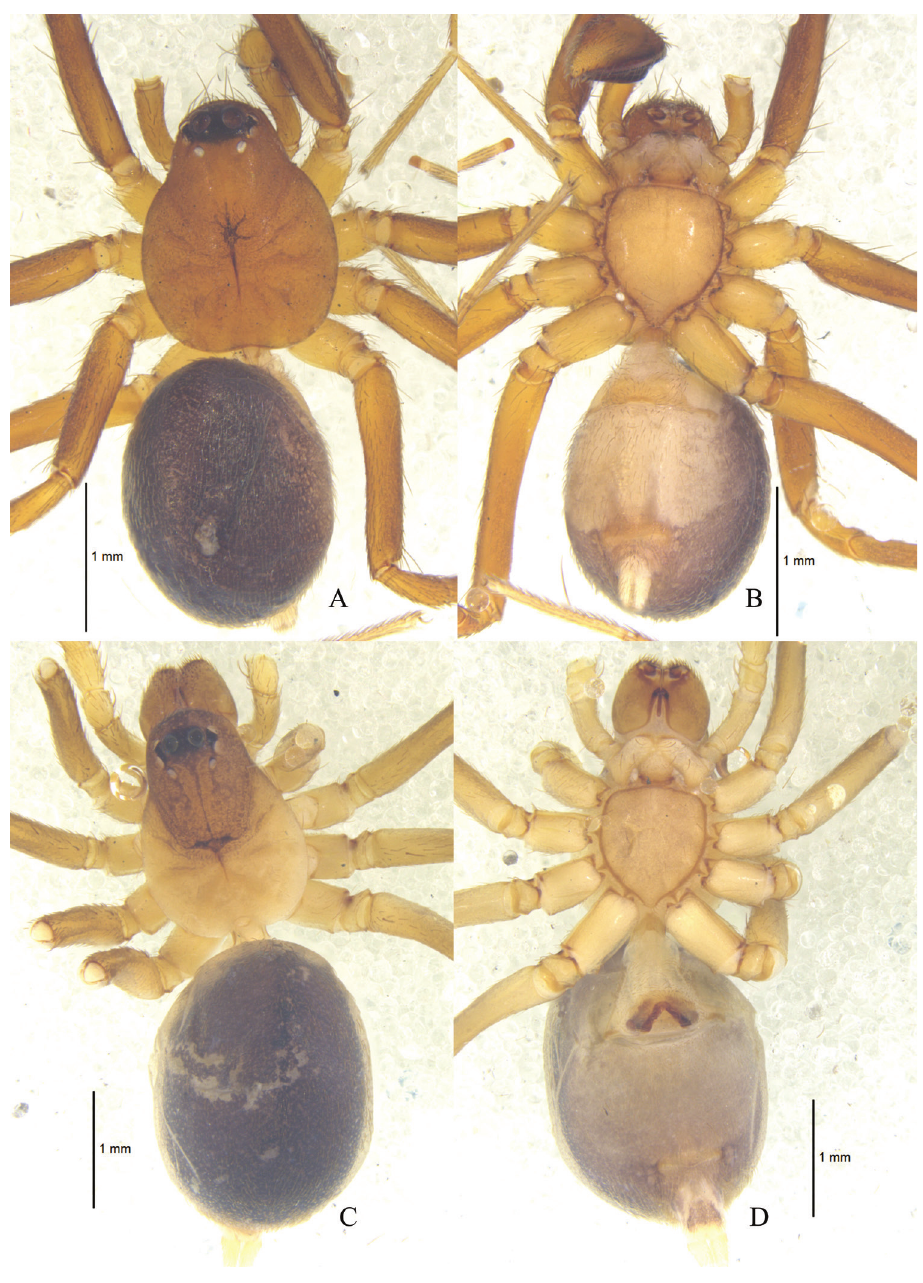
Figure 9. Zodarion chaoyangense Zhu & Zhu, 1983, male holotype ( A, B ) and female paratype ( C, D ) Habitus ( A, C dorsal view B, D ventral